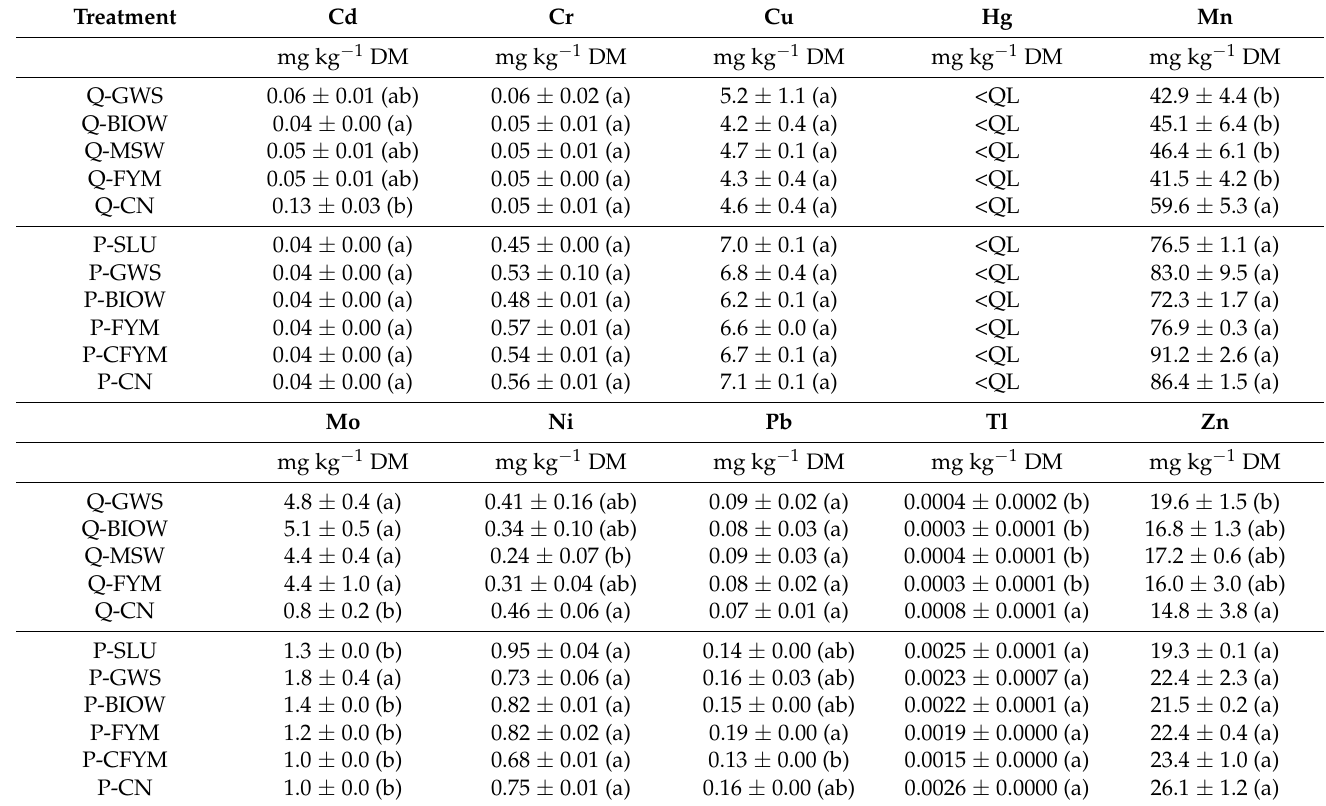
Table 7. Plantlet trace element concentrations (mg kg − 1 DM, DM for dry matter), with the following data presented: mean values ± standard deviation of the four replicates (in each site, abc letters stand for significant difference between treatments with Newman–Keuls and Kruskal–Wallis tests). See Figures 1 and 2 for treatments signification. <QL: at least half of values were lower than the quantification limit.